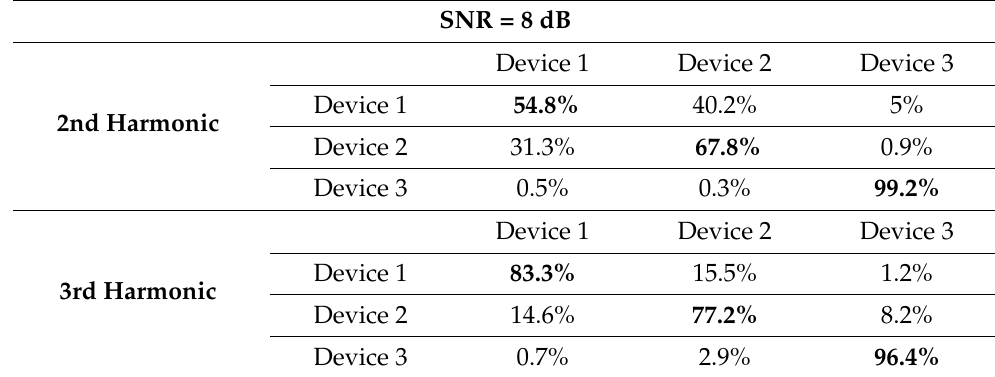
Table 2. Confusion matrices for each harmonic in 3D statistical space for SNR = 8 dB.